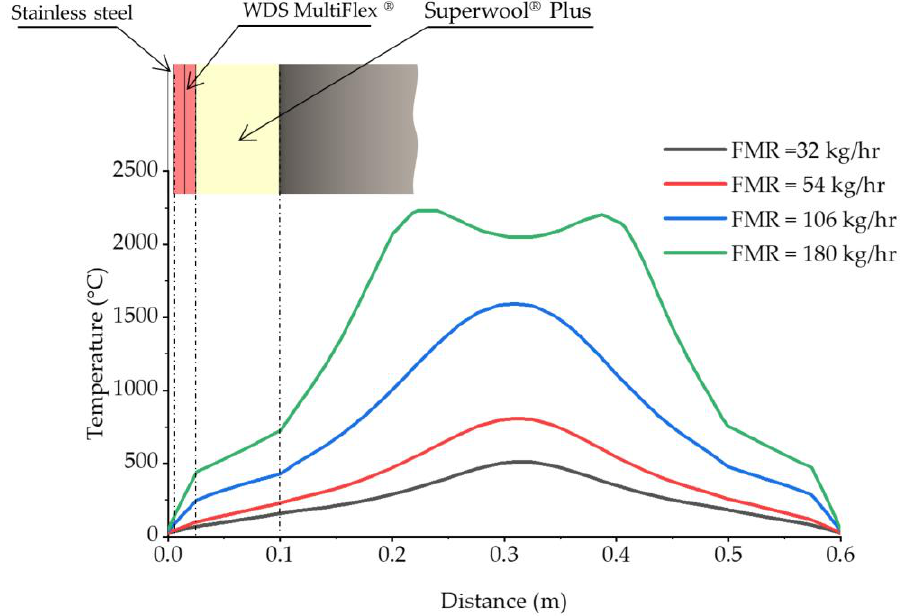
Figure 13. Comparison of temperature profiles at the axial position of z = 3.5 m with different FMRs.